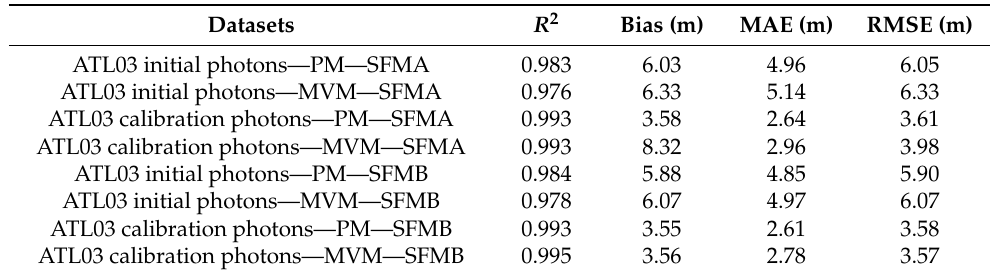
Table 3. Statistical errors of ground elevation using the MVM and PM methods for slope filtering, using ATL03 ground points extracted from the initial and corrected